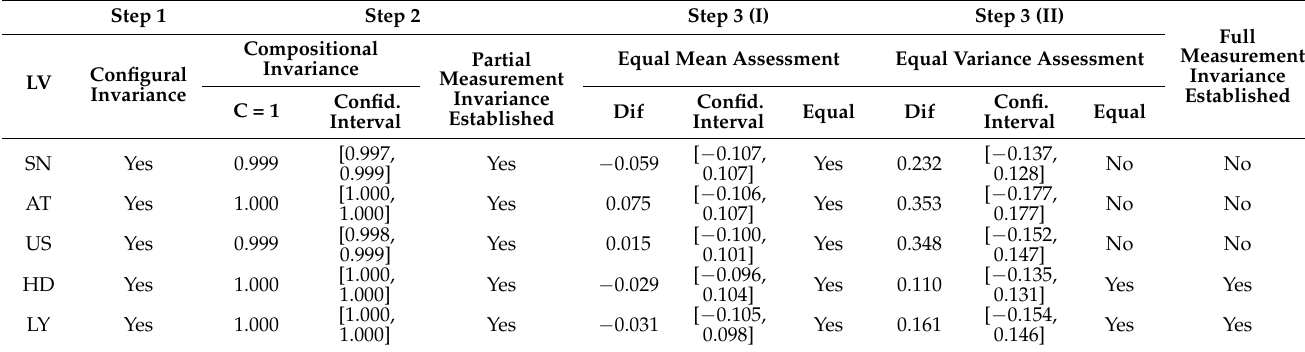
Table 8. Results of Invariance Measurement Testing Using Permutation.